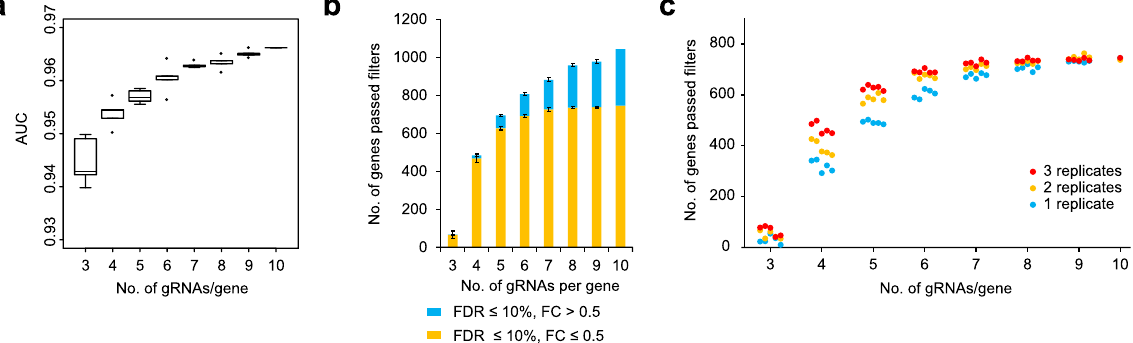
Figure 4. Optimal number of gRNAs per gene and number of replicates. ( a ) Box plots showing area under the curve (AUC) from ROC analysis using different gRNAs per gene. ( b ) The number of depleted genes detected at the indicated FDR and fold change (FC) cut-offs. ( c ) The number of depleted genes detected at FDR ≤ 10% and FC ≤ 0.5 from reduced numbers of replicates for each